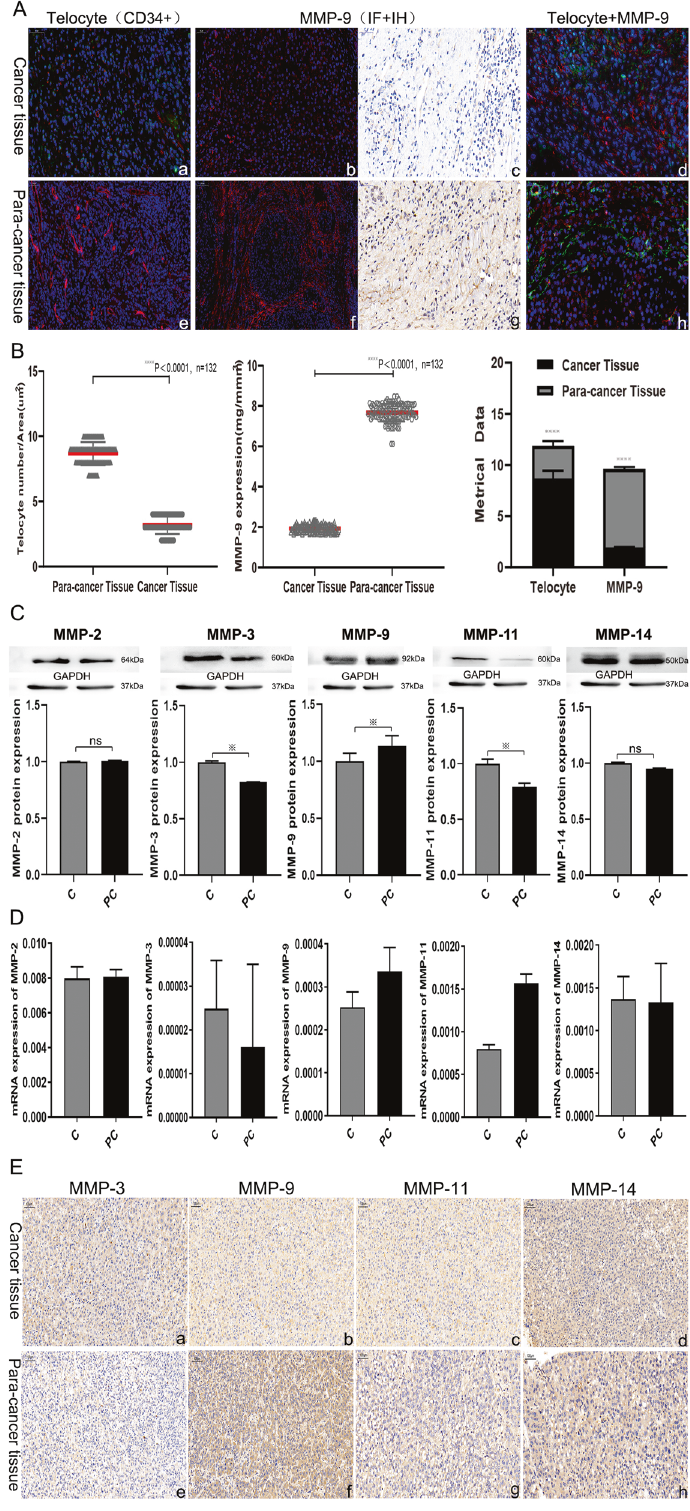
received 2 TC injections in the TC injection group were lower than those of mice in the control group and mice that received only 1 TC injection (Fig. 4L). Lung tissue weight increased in the TC injection group as compared to the control group (Fig. 4K, panel c; 4